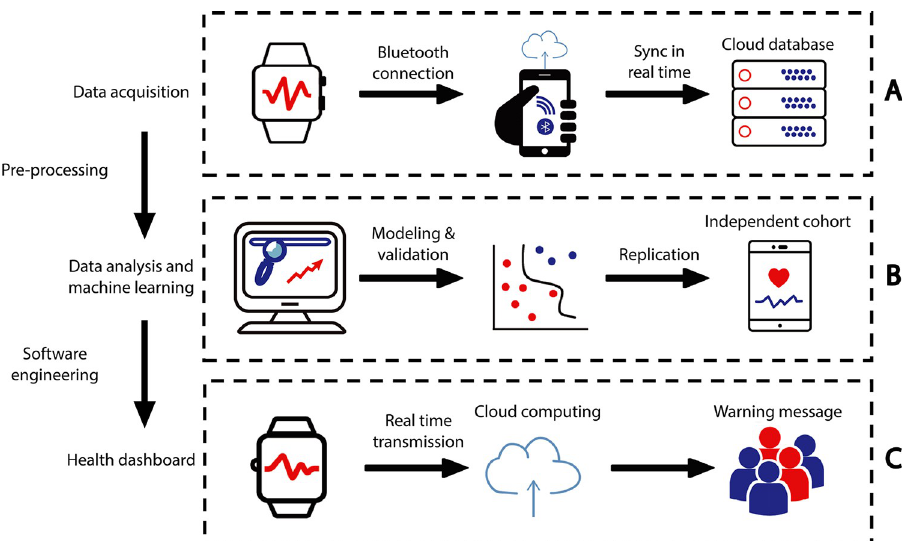
Fig 1. Overview of the LOOP system. The Microsoft Band wristband device is connected via Bluetooth to a nearby smartphone, and the sensor data is transmitted to the smartphone at the real time. The smartphone has a pre-installed dedicated app, which allows the caregiver to record it when the child is having a seizure or other unusual events. This smartphone is also connected to a remote central data server in the cloud via Wi-Fi or cellular network; the recorded data is stored on the remote server for storage and analysis. The smartphone app has an intuitive user interface, allowing the user to access and display historical data, either recent data stored locally on the cell phone or remotely on the cloud